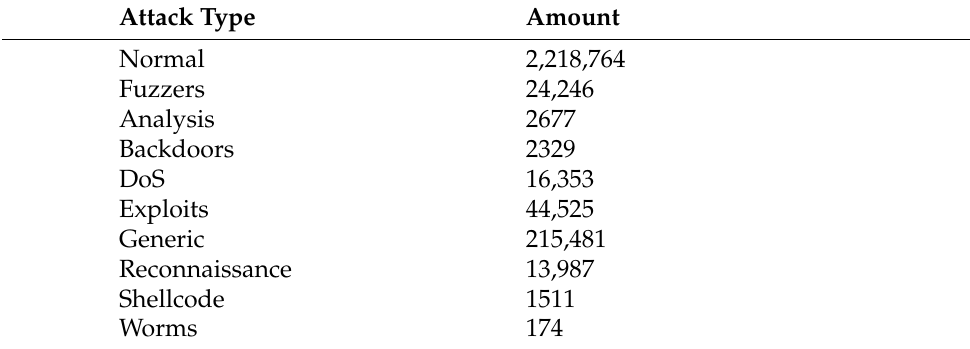
Table 3. List of